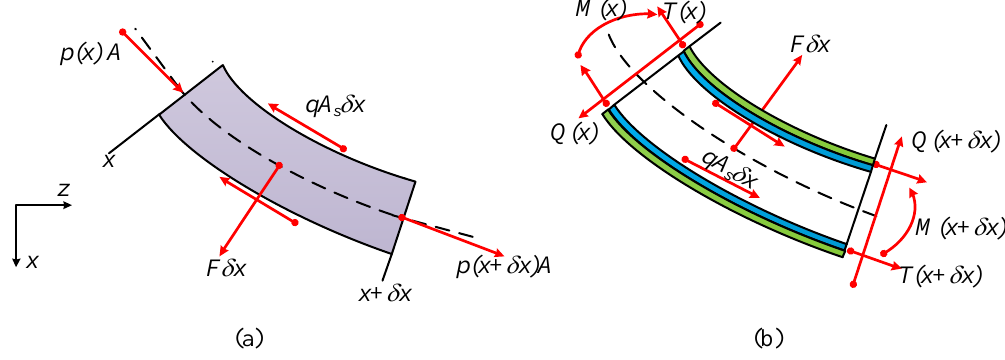
Figure 2. ( a ) Force diagram of the fluid element and ( b ) the piezoelectric composite pipe